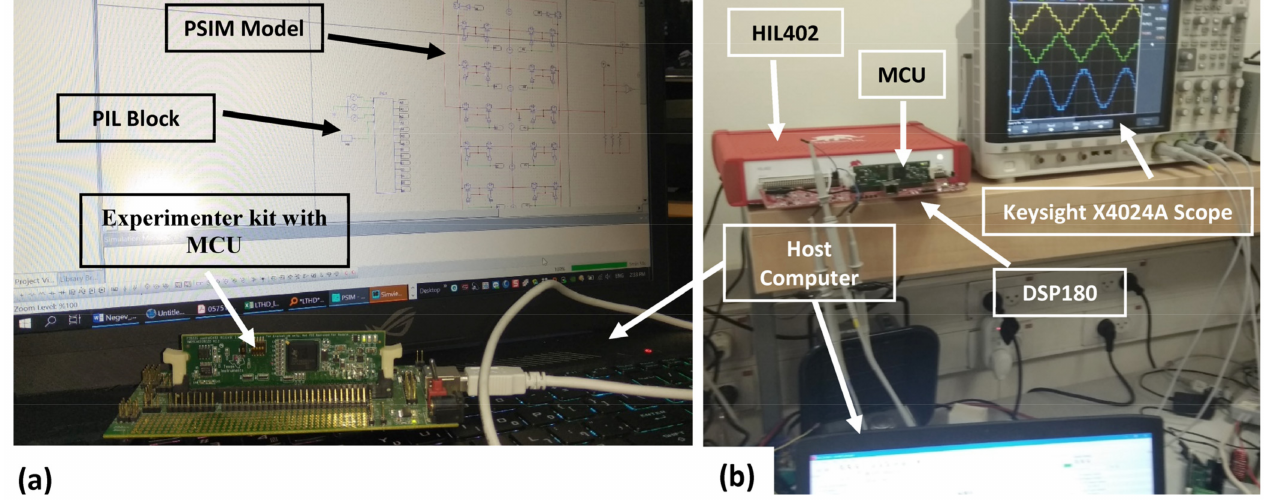
Figure 10. Real-time experimental setups: ( a ) processor in loop, ( b ) controller + hardware in loop. Table 4. Setup parameters for real-time C-HIL base experimental verification. Parameter Symbol Value/Model Total DC-link